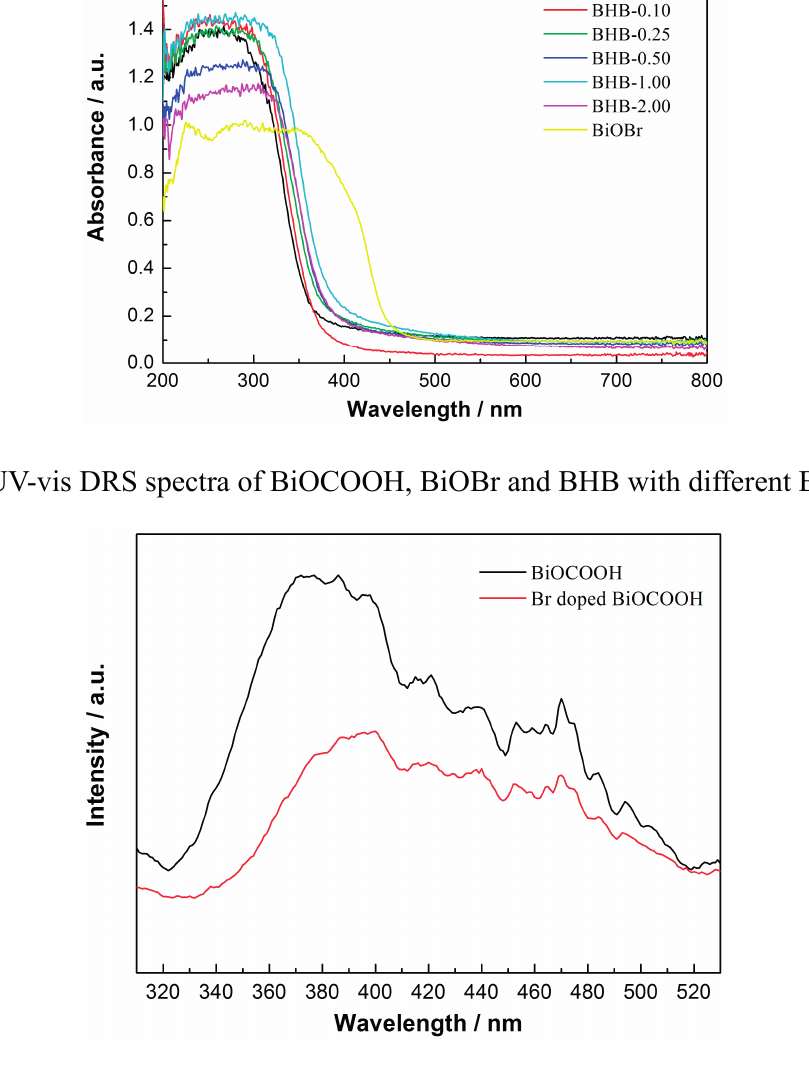
Figure 7. PL spectra of BiOCOOH and Br doped BiOCOOH